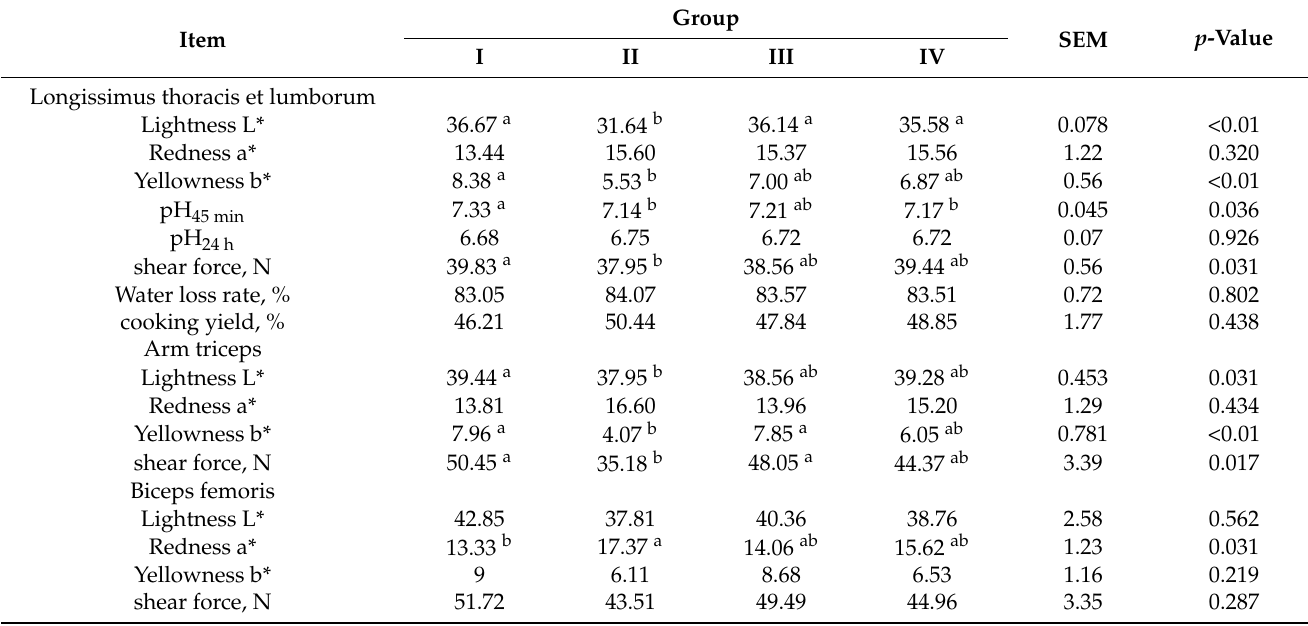
Table 5. Effects of different processing methods of mulberry leaf TMR diet on muscle quality of black goats.